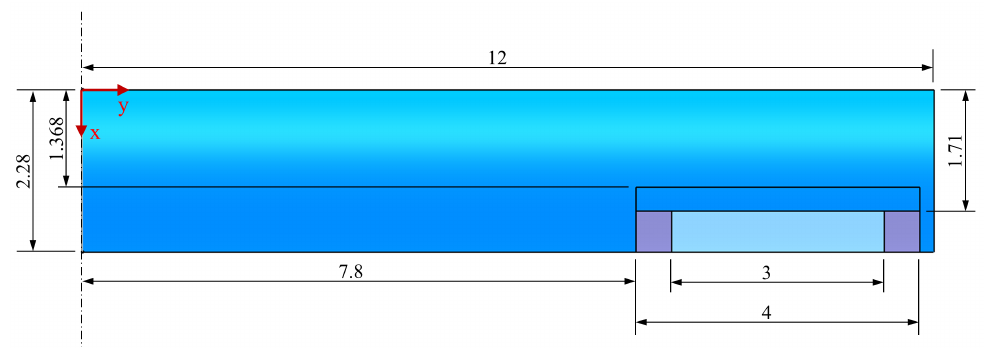
Figure 6. The configuration of the right wing equipped with the morphing